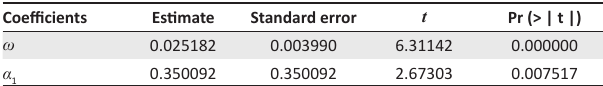
TABLE 3: Autoregressive conditional heteroscedasticity(1) (ARCH[1]) model parameters.